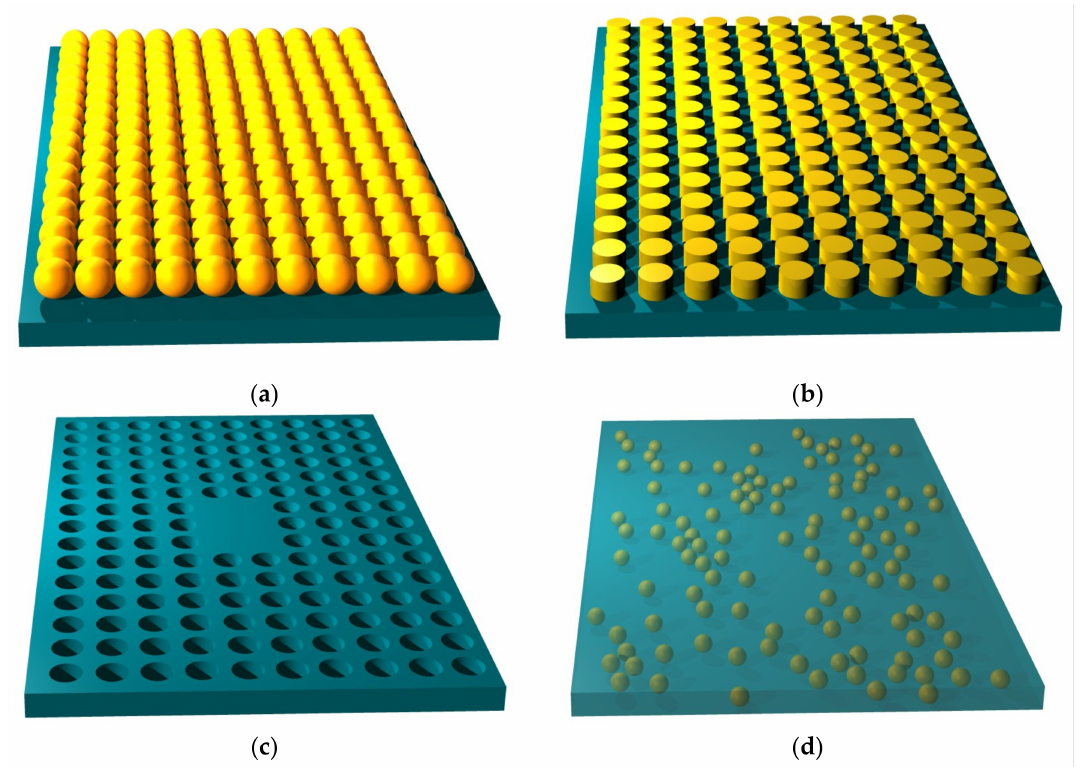
Figure 2. Functionalization of nanomembrane by scatterers. ( a ) self-assembled metal nanospheres fixed to the nanomembrane surface (bottom-up approach); ( b ) deposition of cylindrical metal (gold) scatterers on the nanomembrane (top-down); ( c ) square lattice of circular apertures; middle six aper- tures are intentionally left out, making a defect in the lattice (an optical nanocavity in 2D); ( d ) ran- domly scattered nanospheres within the nanomembrane host material (the nanofiller